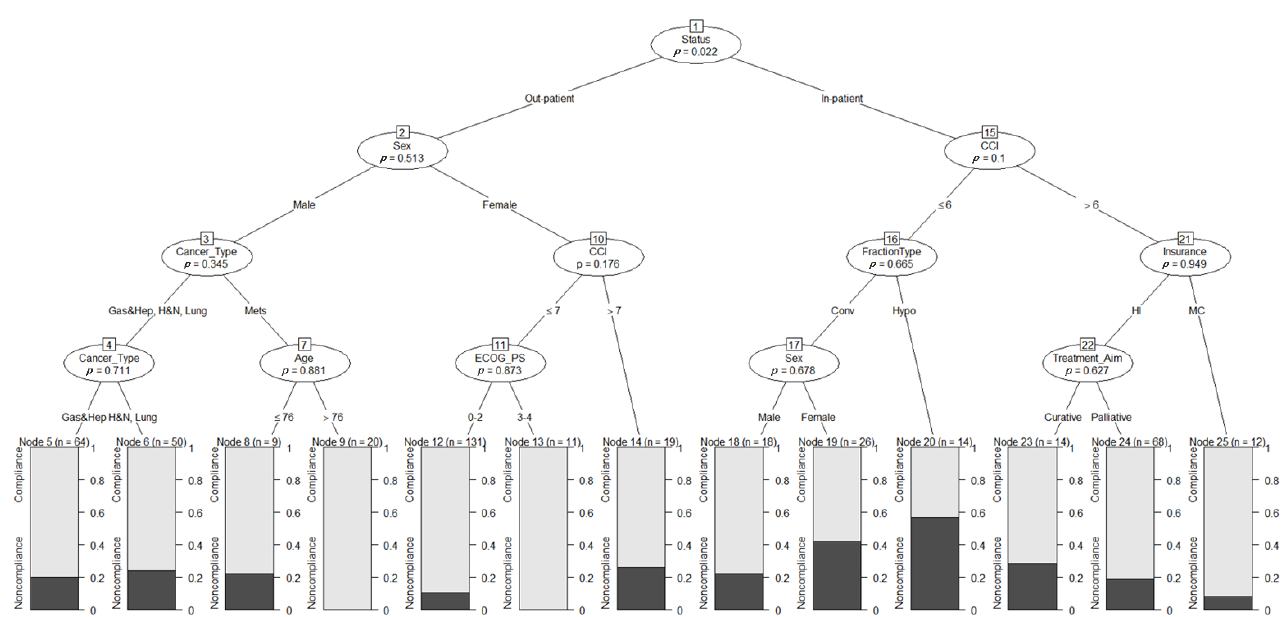
Figure 2. Decision tree for predicting radiotherapy compliance in elderly cancer patients. The oval structures represent the variables that branch out to form the tree. The branches connect the variables and hold the condition for the splits. The rectangle structures that do not branch any further on the tree are the leaf or decision node from which the probability of compliance (white) and noncompliance (black) is read. The values at the top of the leaf nodes indicate the number of patients in that node, and the p-values in the oval structures indicate the significance level of the variable.